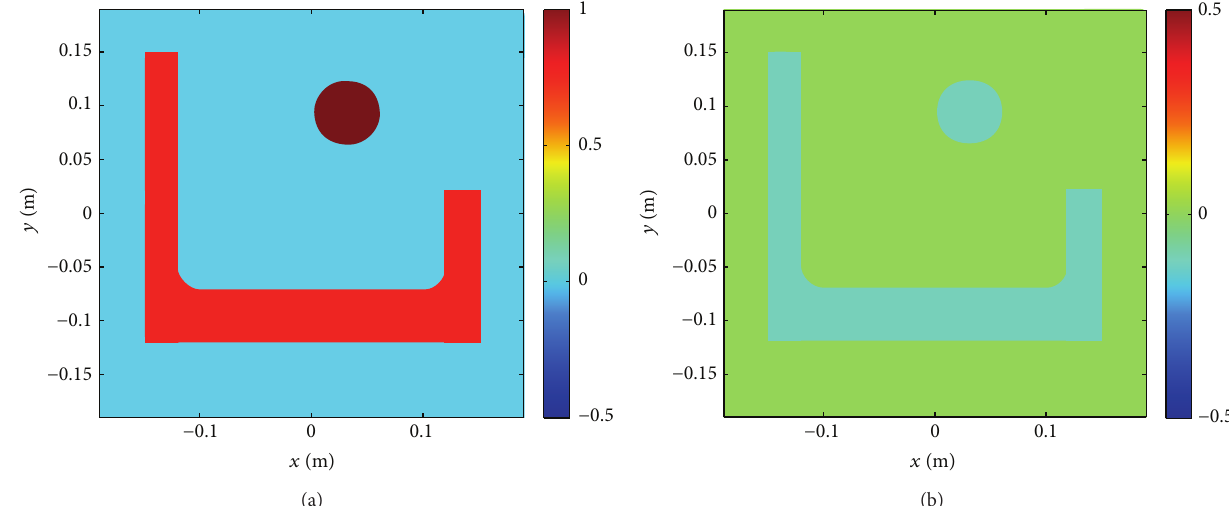
Figure 3: Example 2: reference profile. (a) Real and (b) imaginary parts of reference contrast